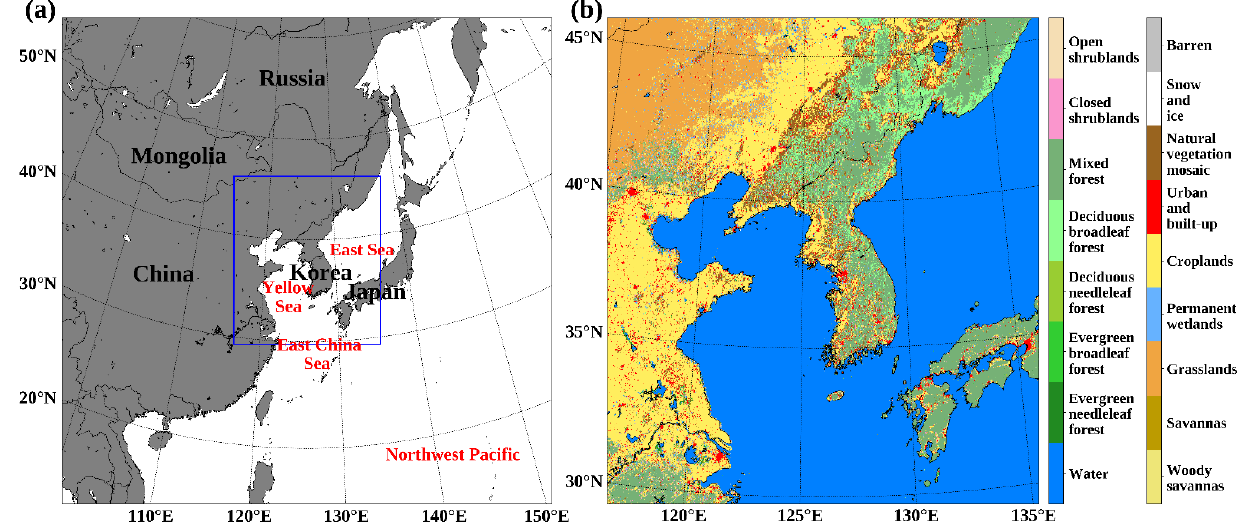
Figure 1. ( a ) Map of East Asia including Korea, where the blue rectangle indicates the study area, and ( b ) MODIS land cover from the Annual International Geosphere – Biosphere Program around the Korean Peninsula in 2019.